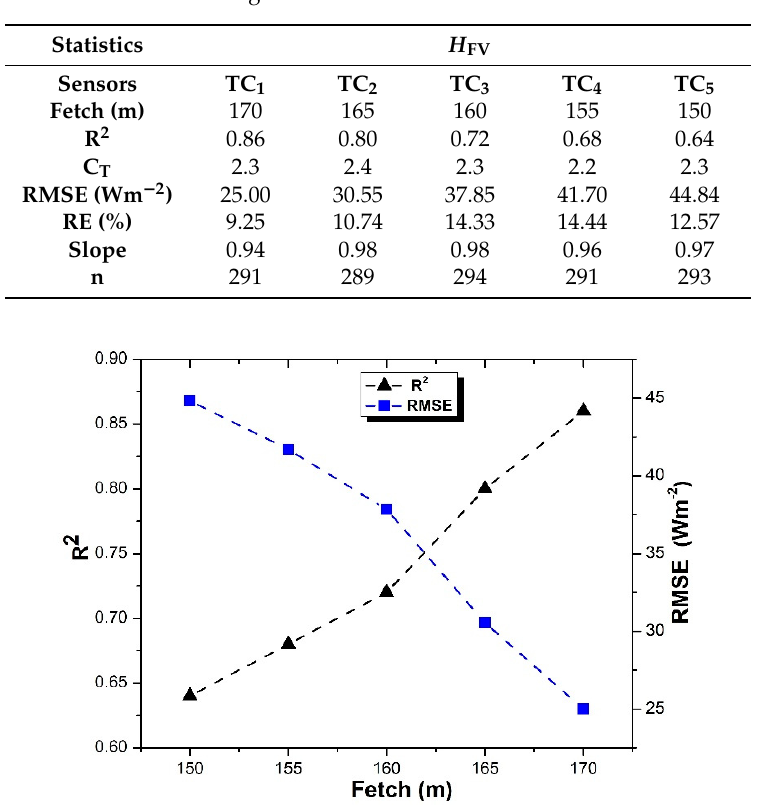
Table 4. Statistical parameters of the regressions between H EC and H FV at the different positions: R 2 , the similarity constant C T , RMSE, RE, and slope. n is the number of data points in each regression. Fetch is the distance from the field edge for the dominant wind direction.